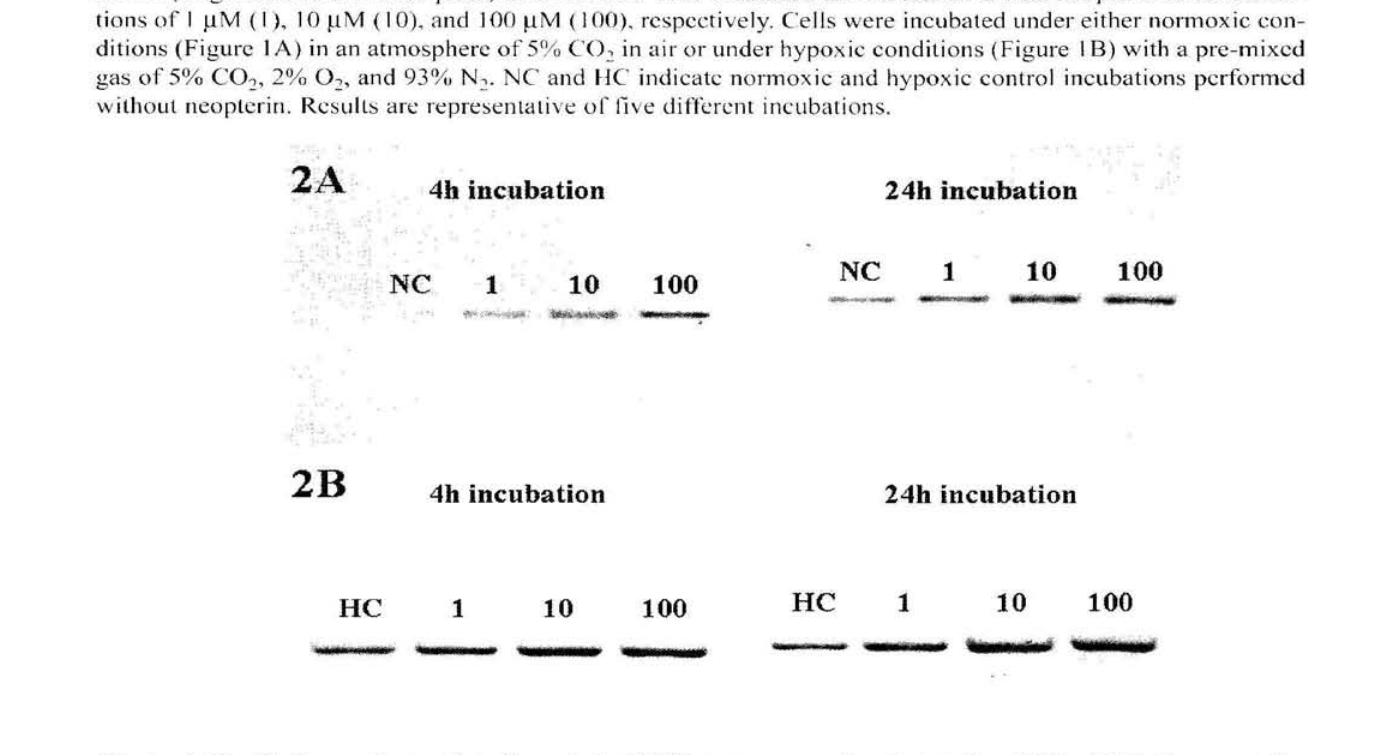
Figure 2. Qualitative analyses of erythropoietin (EPO) gene expression detected as EPO-cDNA (fragment size 253 base pairs) in OVCAR-3 cells incubated for 4 h and 24 h w ith neopterin at concentrations of 1 μΜ ( I ), 10 μΜ ( 10), and 100 μΜ (100), respectively. Cells were incubated under either normoxic conditions (Figure 2A) in an atmosphere of 5% C 0 2 in air or under hypoxic conditions (Figure 2B) with a pre-mixed gas of 5% CO->, 2% 0 2 , and 93% N 2 . NC and HC indicate normoxic and hypoxic control incubations performed without neopterin. Results are representative of five different